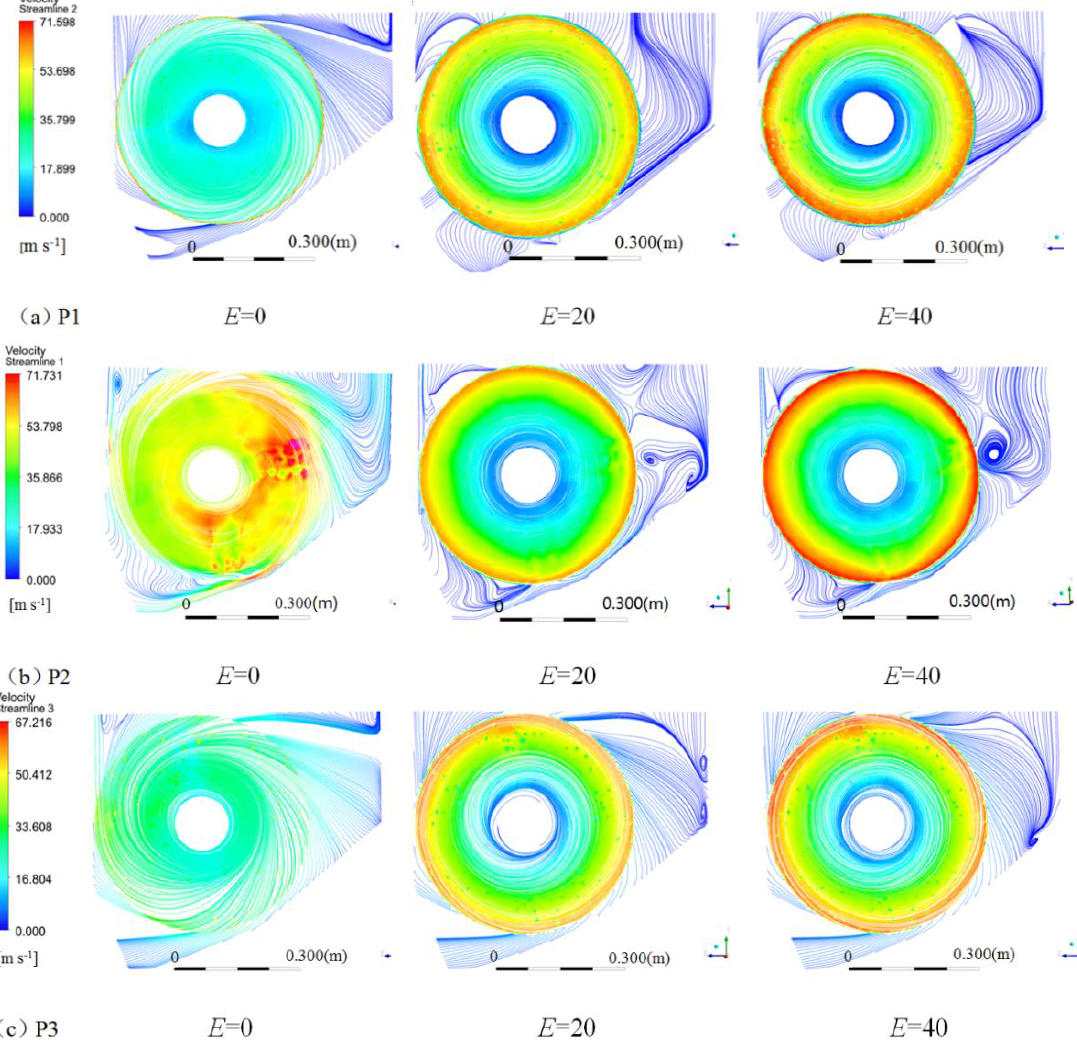
Figure 18. Streamline diagram of each section under different number of wind blades installed. ( a ) P1; ( b ) P2; ( c ) P3.